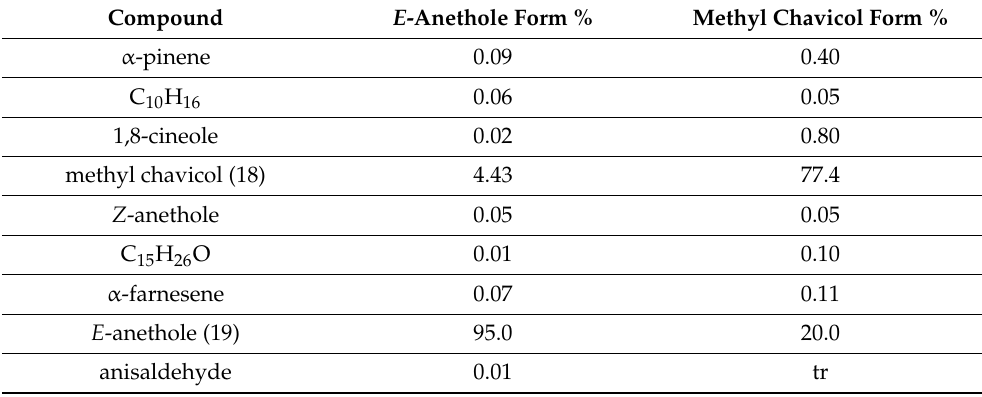
Table 14. Composition of the leaf oils of the two chemotypes of Syzygium anisatum . Compound E -Anethole Form % Methyl Chavicol Form % α -pinene